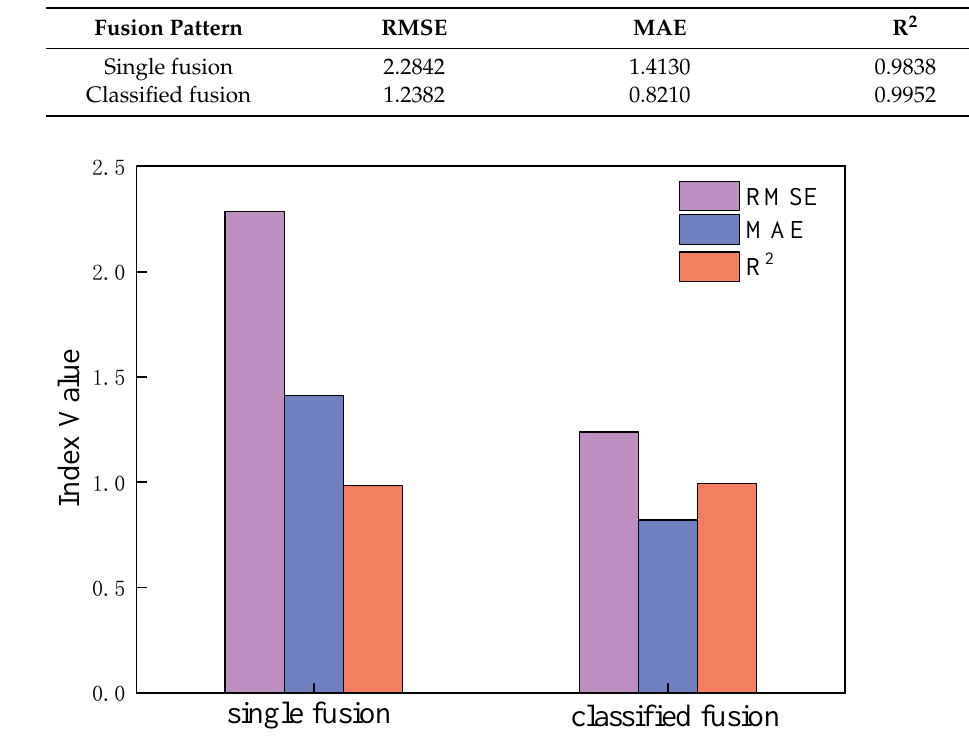
Figure 14. The chart of evaluation indexes of IPSO – LSTM in different fusion patterns.